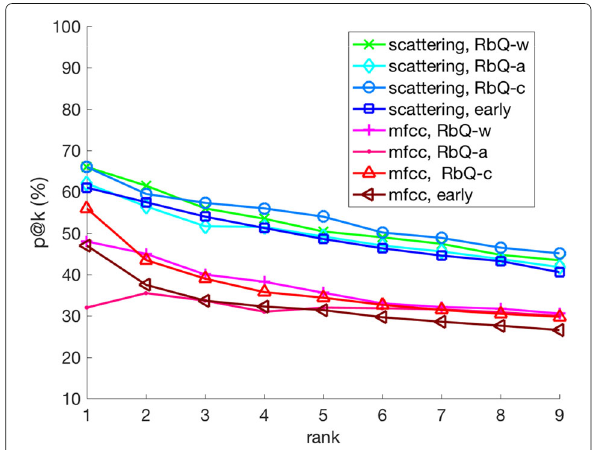
Fig. 6 Acoustic scene similarity retrieval in the DCASE 2013 private dataset: precisions at rank k ( p @ k ) obtained for MFCCs and scattering with logarithmic